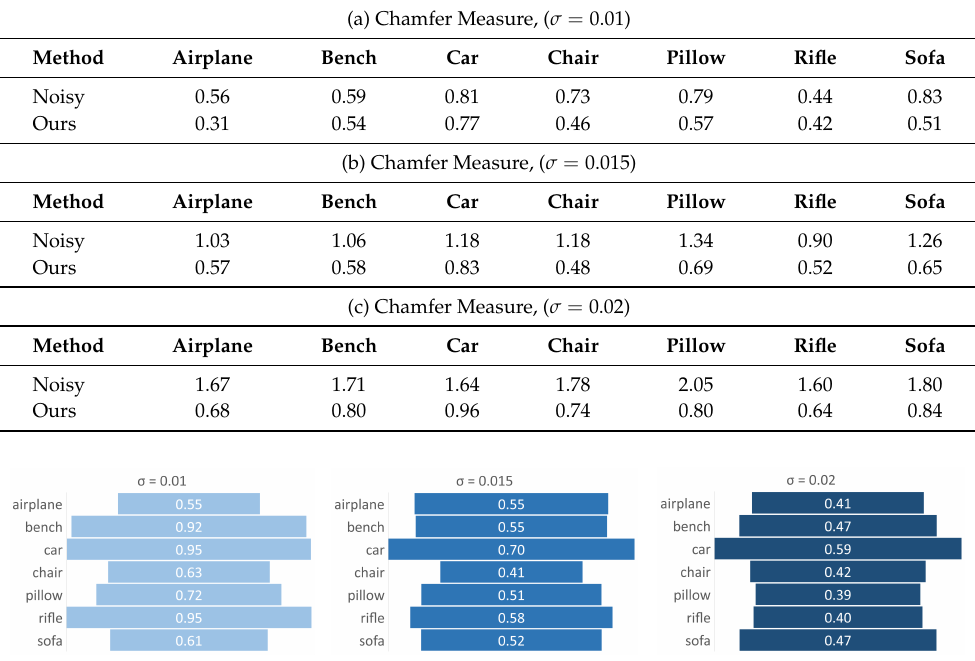
Figure 6. C2C scores generated by CMD-Net are normalized by their noisy counterparts. Left-most, middle, and right-most images are of σ = 0.01, σ = 0.015, and σ = 0.02, respectively.